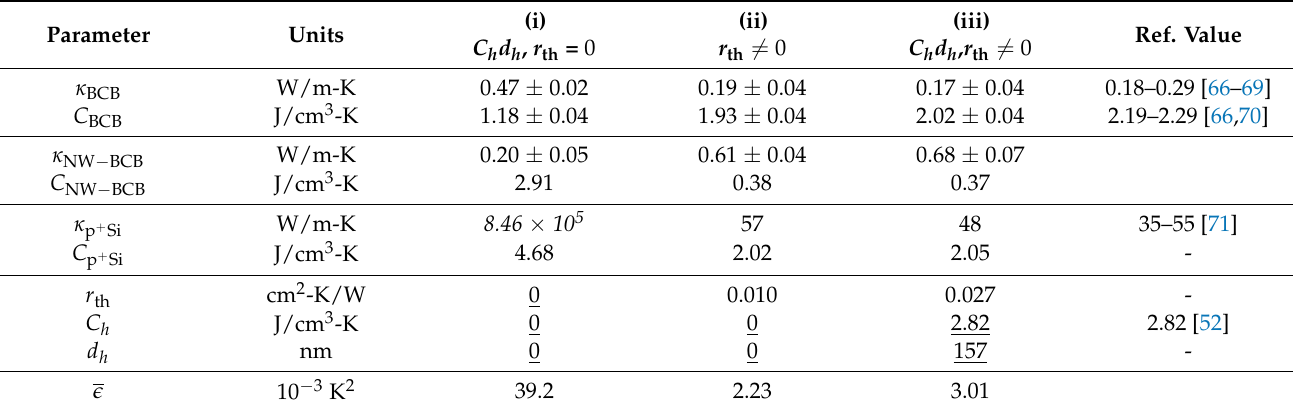
Table A2. Fitted parameter values for sample B.